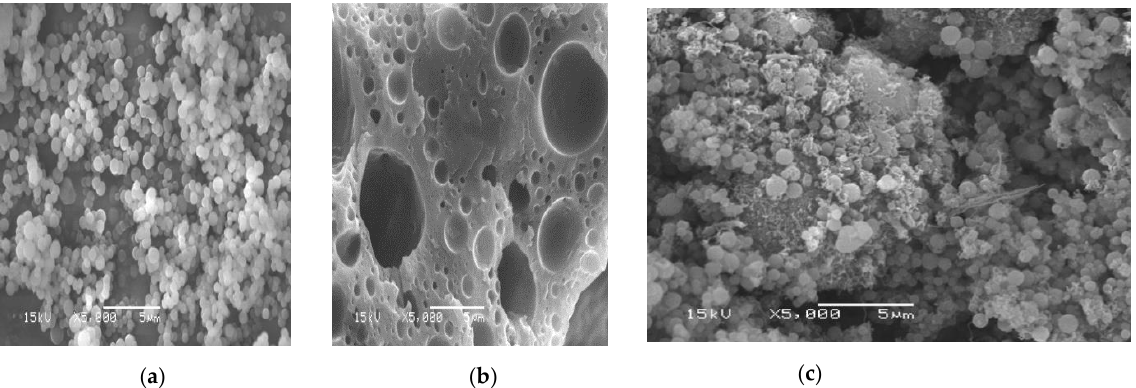
Figure 3. SEM photographs of ( a ) P(AN- co -St), ( b ) SP(AN- co -St), and ( c ) P(AN- co -St)/MWCNTs. Table 2. Particle size distribution analysis of nanocomposites.